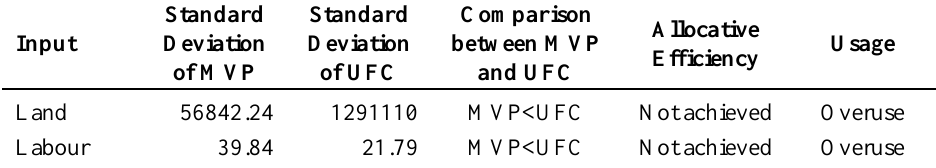
Table 8: Allocative Efficiency of Each Input Standard Standard Comparison Allocative Input Deviation Deviation between MVP Usage Efficiency of MVP of UFC and UFC Land 56842.24 1291110 MVP<UFC Not achieved Overuse Labour 39.84 21.79 MVP<UFC Not achieved